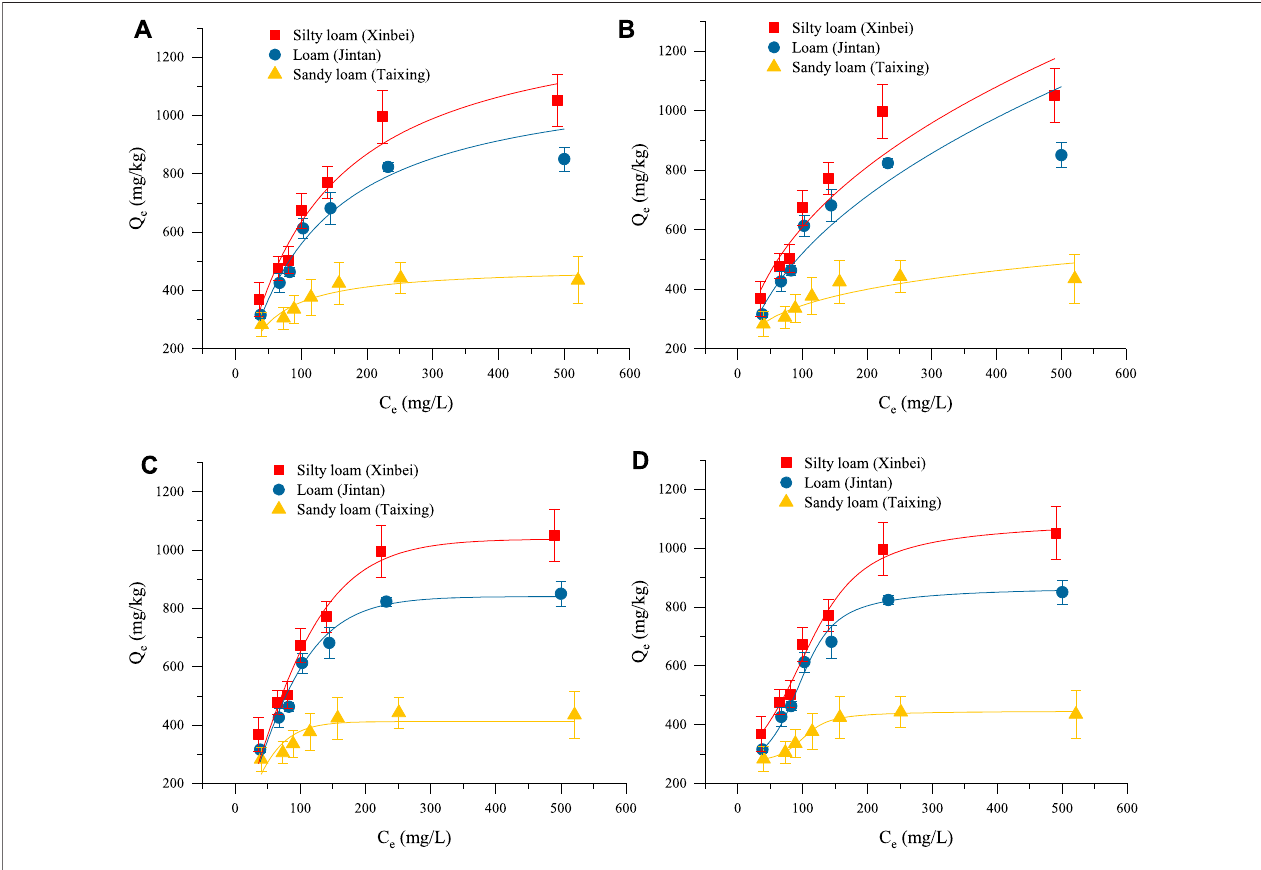
FIGURE 3 | Fitting effects of adsorption thermodynamic models: (A – D) show the fi tting results for the adsorption thermodynamics of NH 4+ -N in the three kinds of soils obtained by the Langmuir equation, the Freundlich equation, the Plplatt equation, and the Langevin model, respectively, at a temperature of 25 ± 1 ° C.